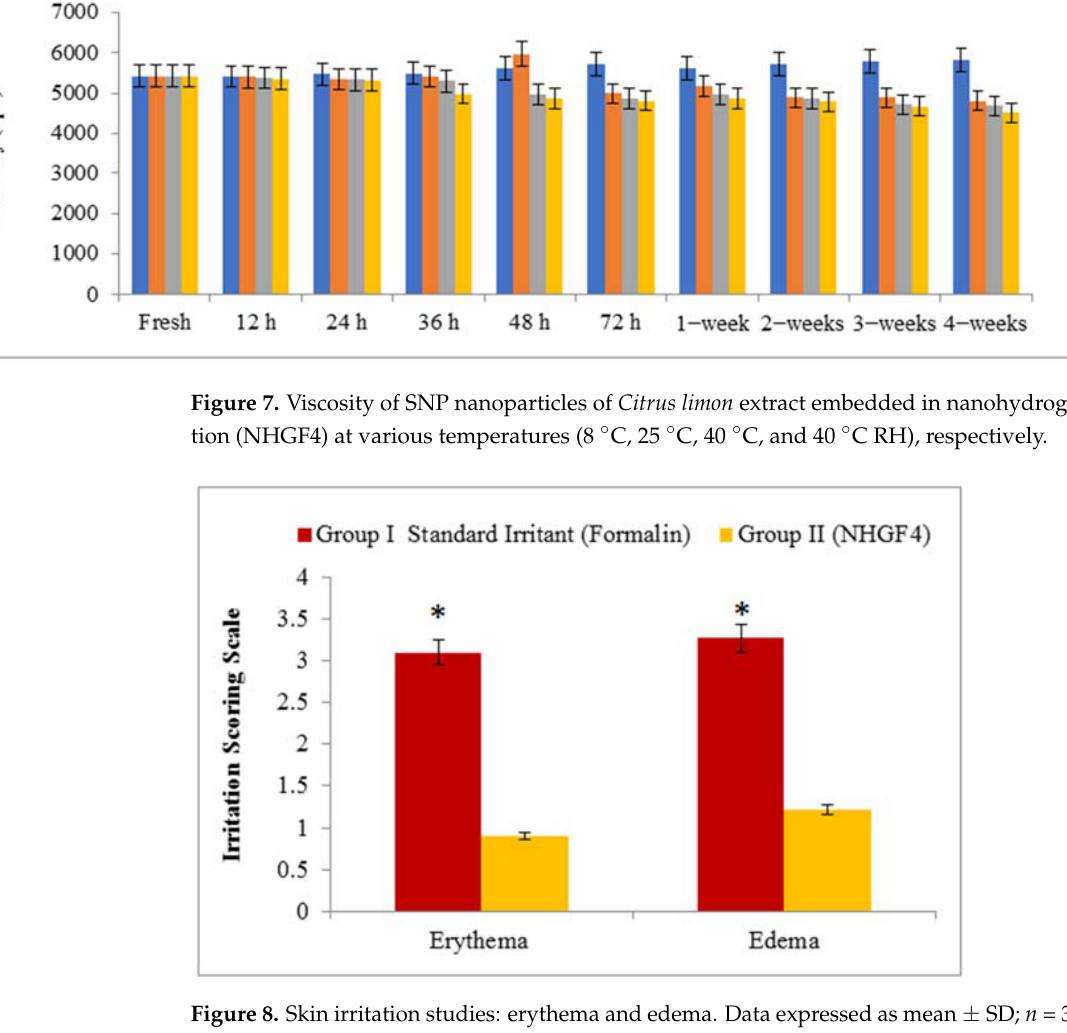
· Gels 2023 , 9 , x FOR PEER REVIEW 8 of 17